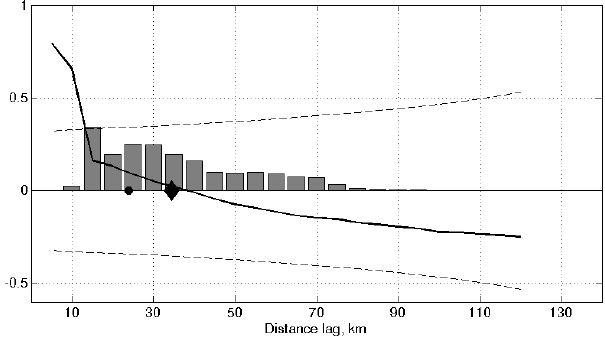
Figure A1. Regional-mean decorrelation scales (radii): the black curve is the mean autocorrelation function, and the black diamond is the mean of the decorrelation scales, while the black disk is the decorrelation scale computed from the mean autocorrelation func- tion (black curve). Dash lines mark the level of significance of the mean autocorrelation function. Bars present the normalized his- togram of regional-mean eddy